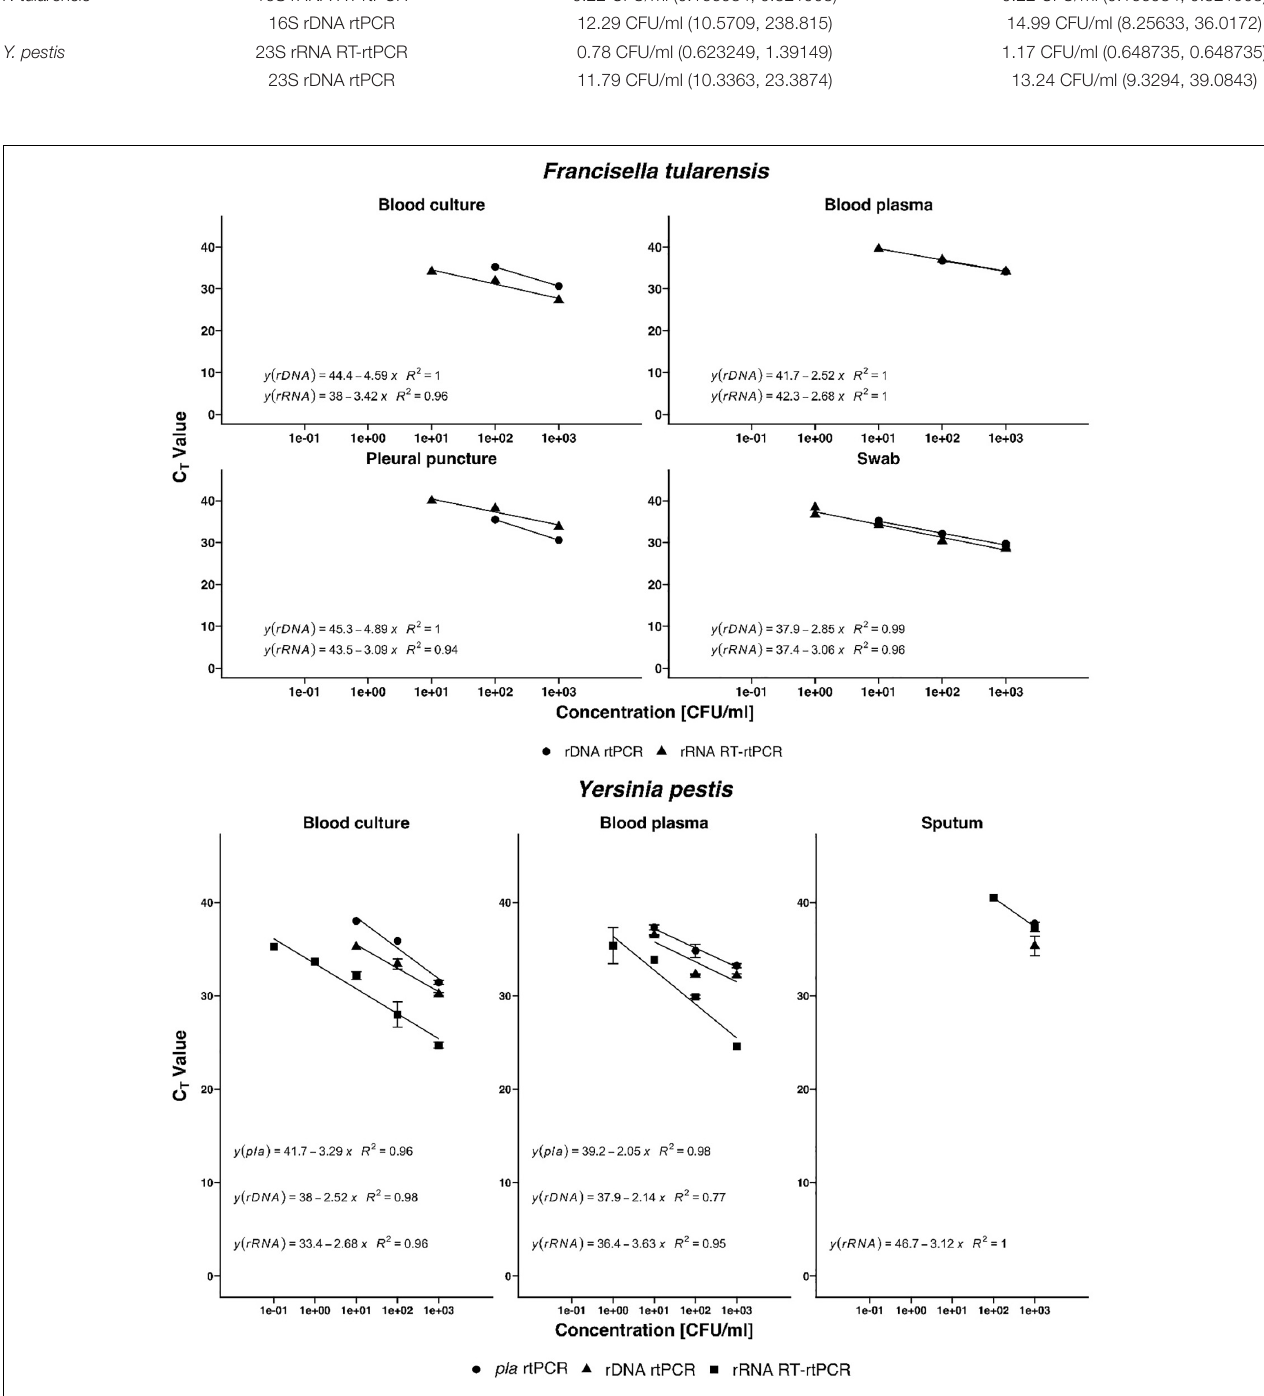
FIGURE 3 | Validation of the new real-time PCR (rtPCR) and reverse transcriptase (RT)-rtPCR assays, respectively, for Francisella tularensis and Yersinia pestis with clinical sample matrices using blood culture, blood plasma, pleural puncture, swab, and sputum. Coefficient of determination ( R 2 ) is determined by linear regression analysis, indicated by the respective formula. Error bars represent the SD of three independent replicates.